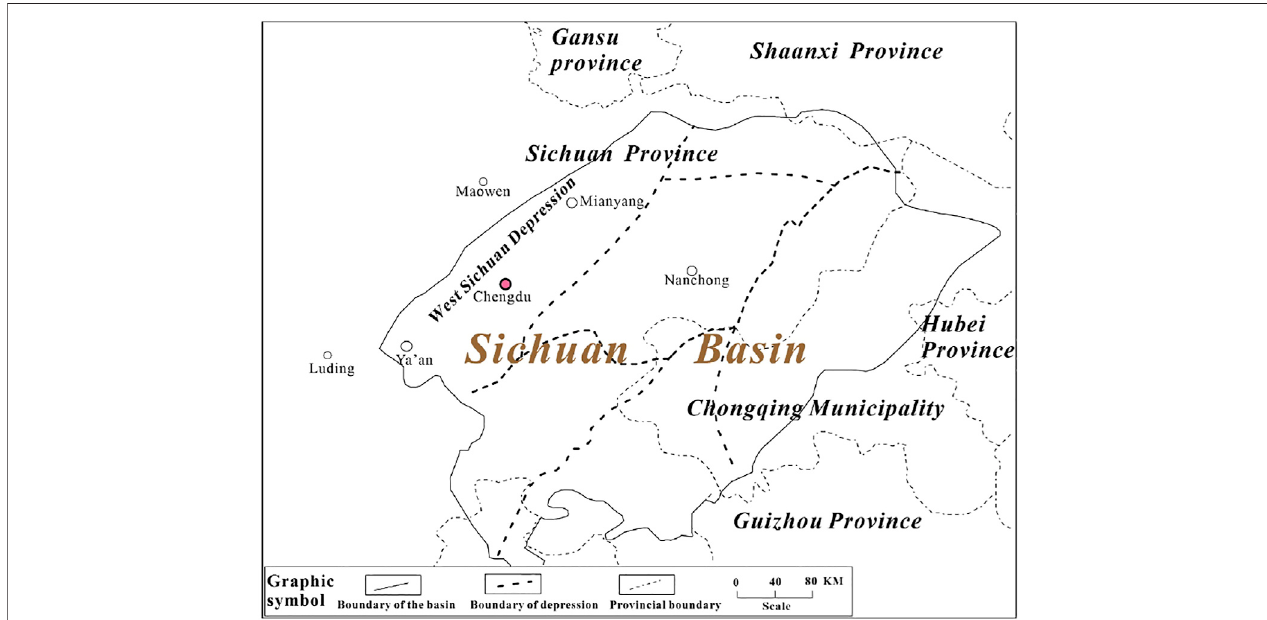
FIGURE 1 | Location of the West Sichuan depression.